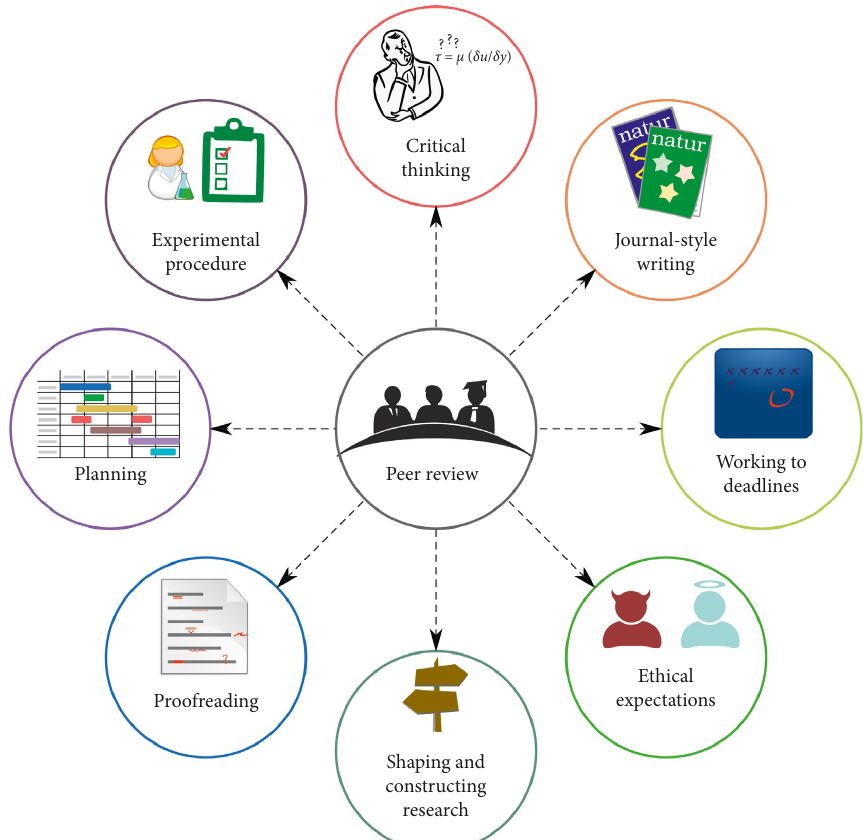
Figure 2: Overview of professional skills needed for ECRs that can be impacted by peer-reviewing